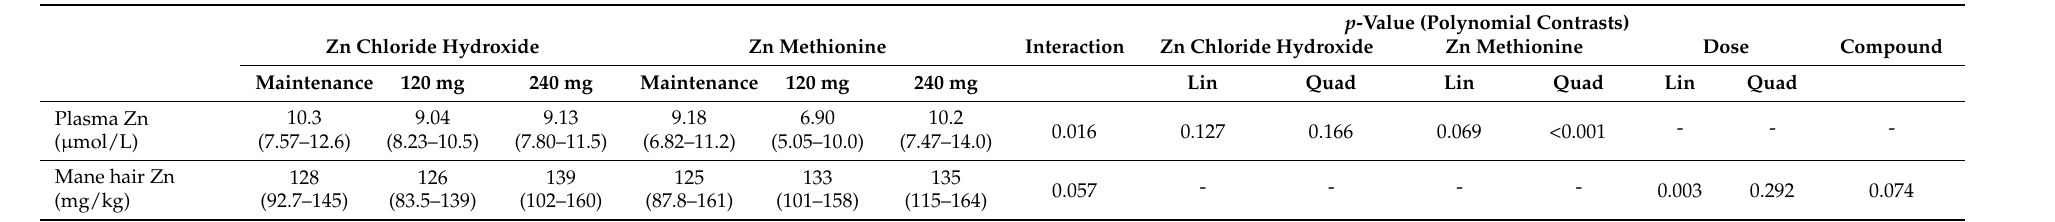
Table 5. Impact of increasing doses of Zn chloride hydroxide and Zn methionine in a diet 1 on the Zn concentrations in the plasma and mane hair of healthy adult horses ( n = 2) and ponies ( n = 8). Median